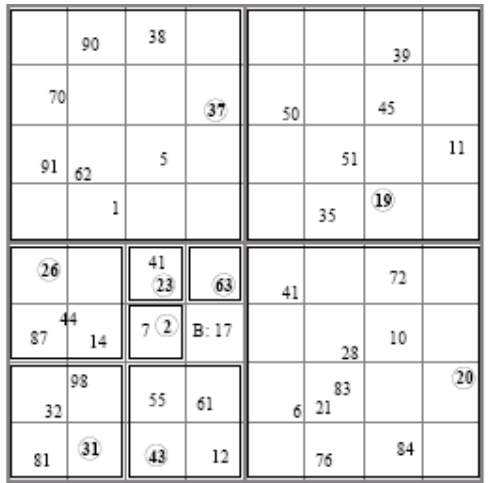
Figure 18. The location server of B in different order